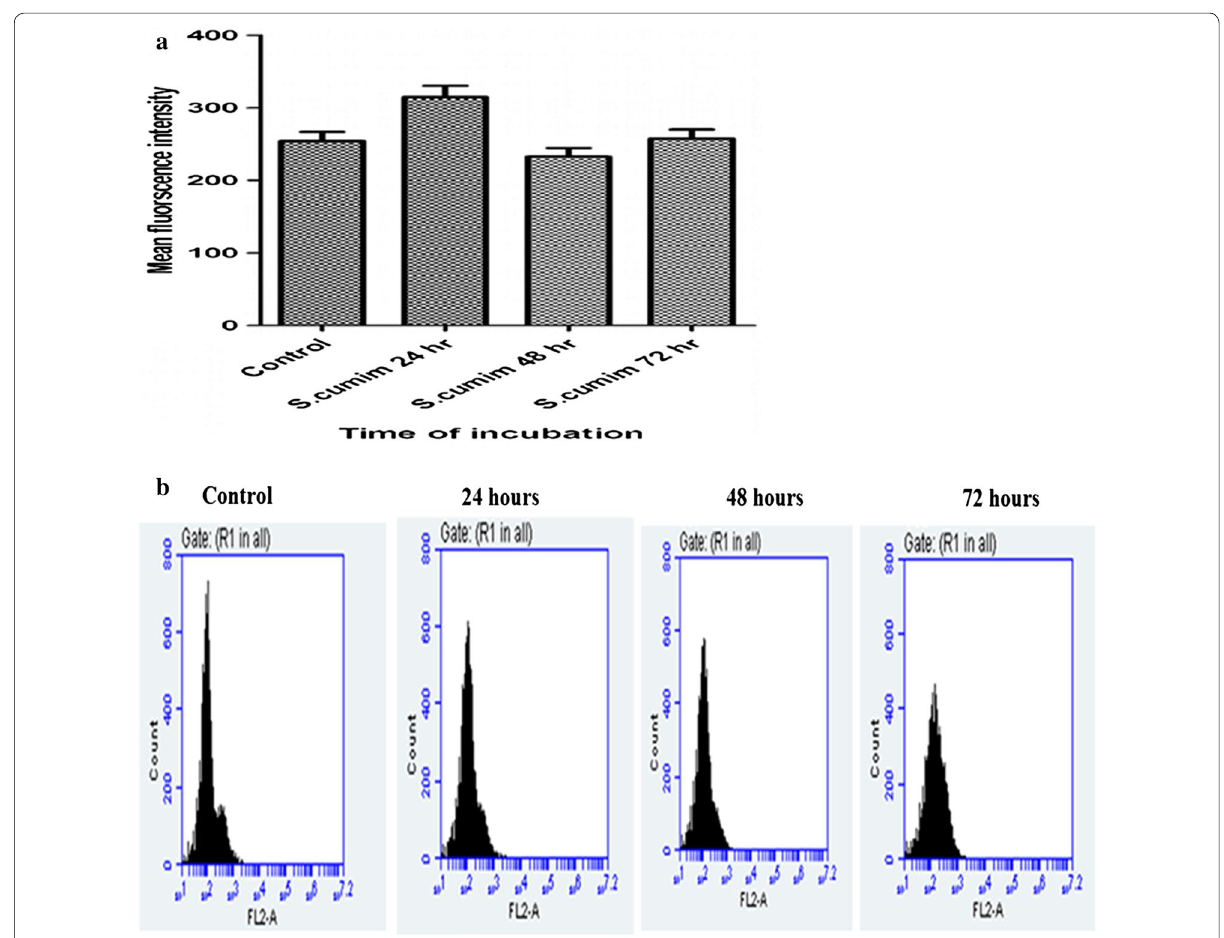
Fig. 3 a Membrane permeabilization of Bacillus subtilis MTCC 2413 by Syzygium cumini methanolic seed extract, using propidium iodide (PI) through flow cytometer technique. A total of 10,000 cells were acquired for each flow cytometric analysis. b Mean fluorescence intensity of propidium iodide in Bacillus subtilis cells exposed to Syzygium cumini on same concentration at varying period of time. b Effect of Syzygium cumini methanolic seed extract on membrane permeabilization of Bacillus subtilis :Histograms of Bacillus subtilis bacterial cells treated with Syzygium cumini methanolic seed extract for 24, 48 and 72 h, then stained with PI and analysed by flow